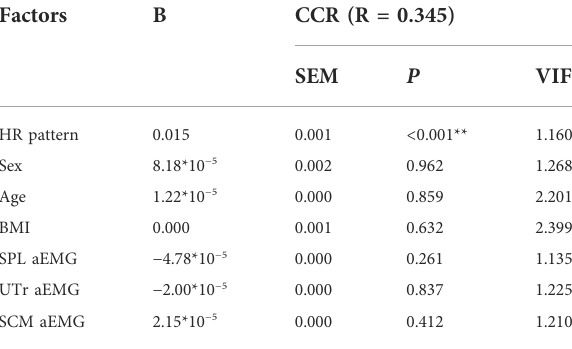
TABLE 5 Multiple linear regression analysis for the cervical rotating